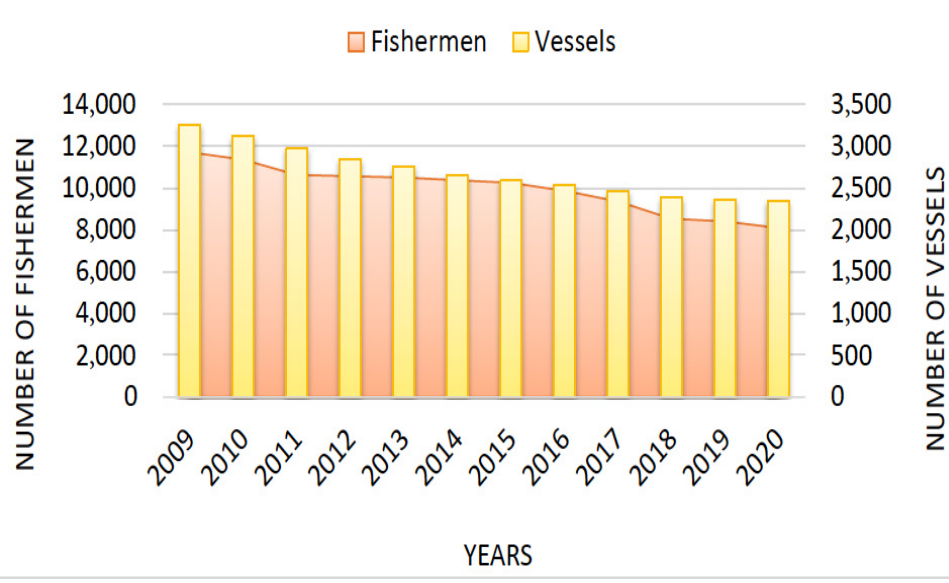
Figure 4. Evolution of the landed fishery (live weight) and its value in the Spanish Mediterranean (2004–2019). Annual average values 6 .